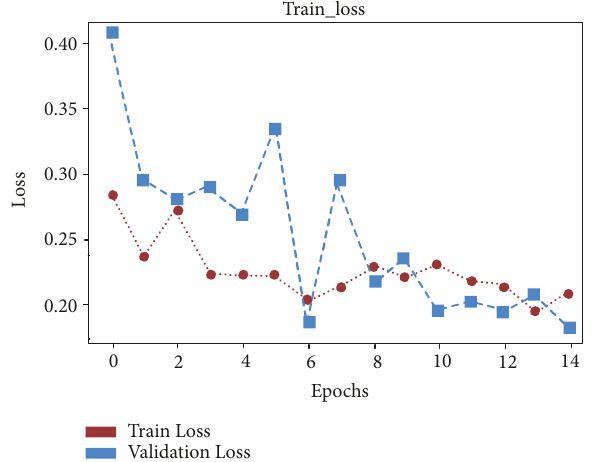
Figure 4: Categorical cross-entropy LSTM.